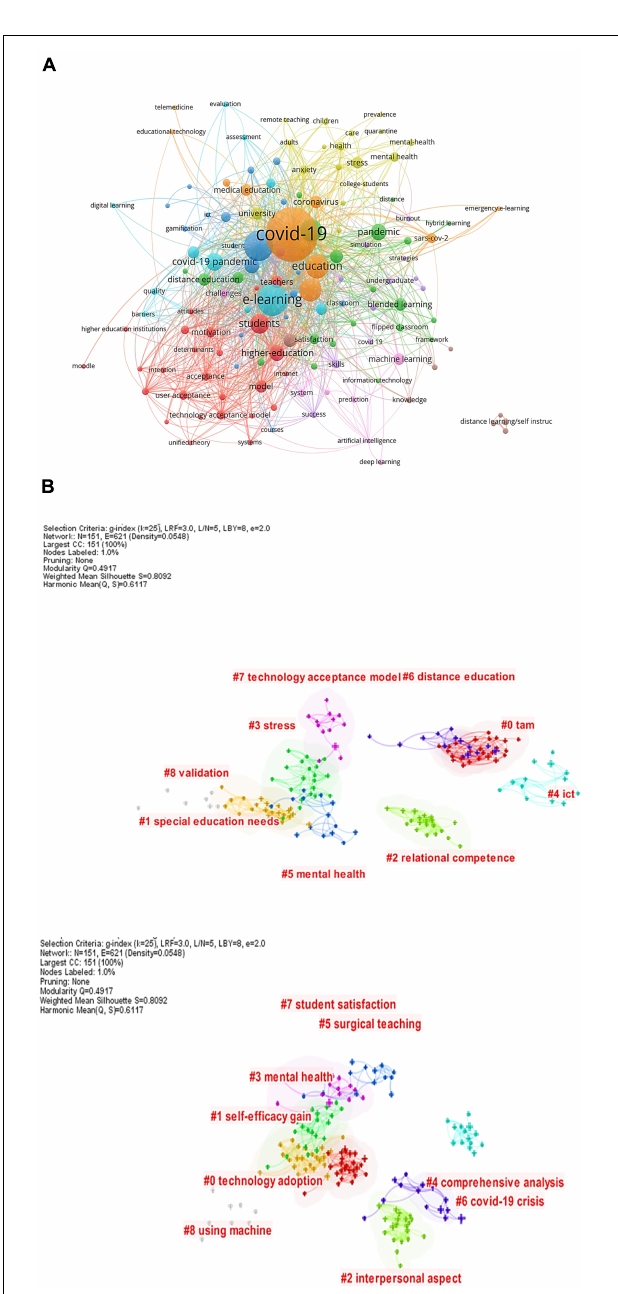
FIGURE 2 | (A) Network of keywords (VOSviewer outputs). (B) Network of keywords (CiteSpace outputs).